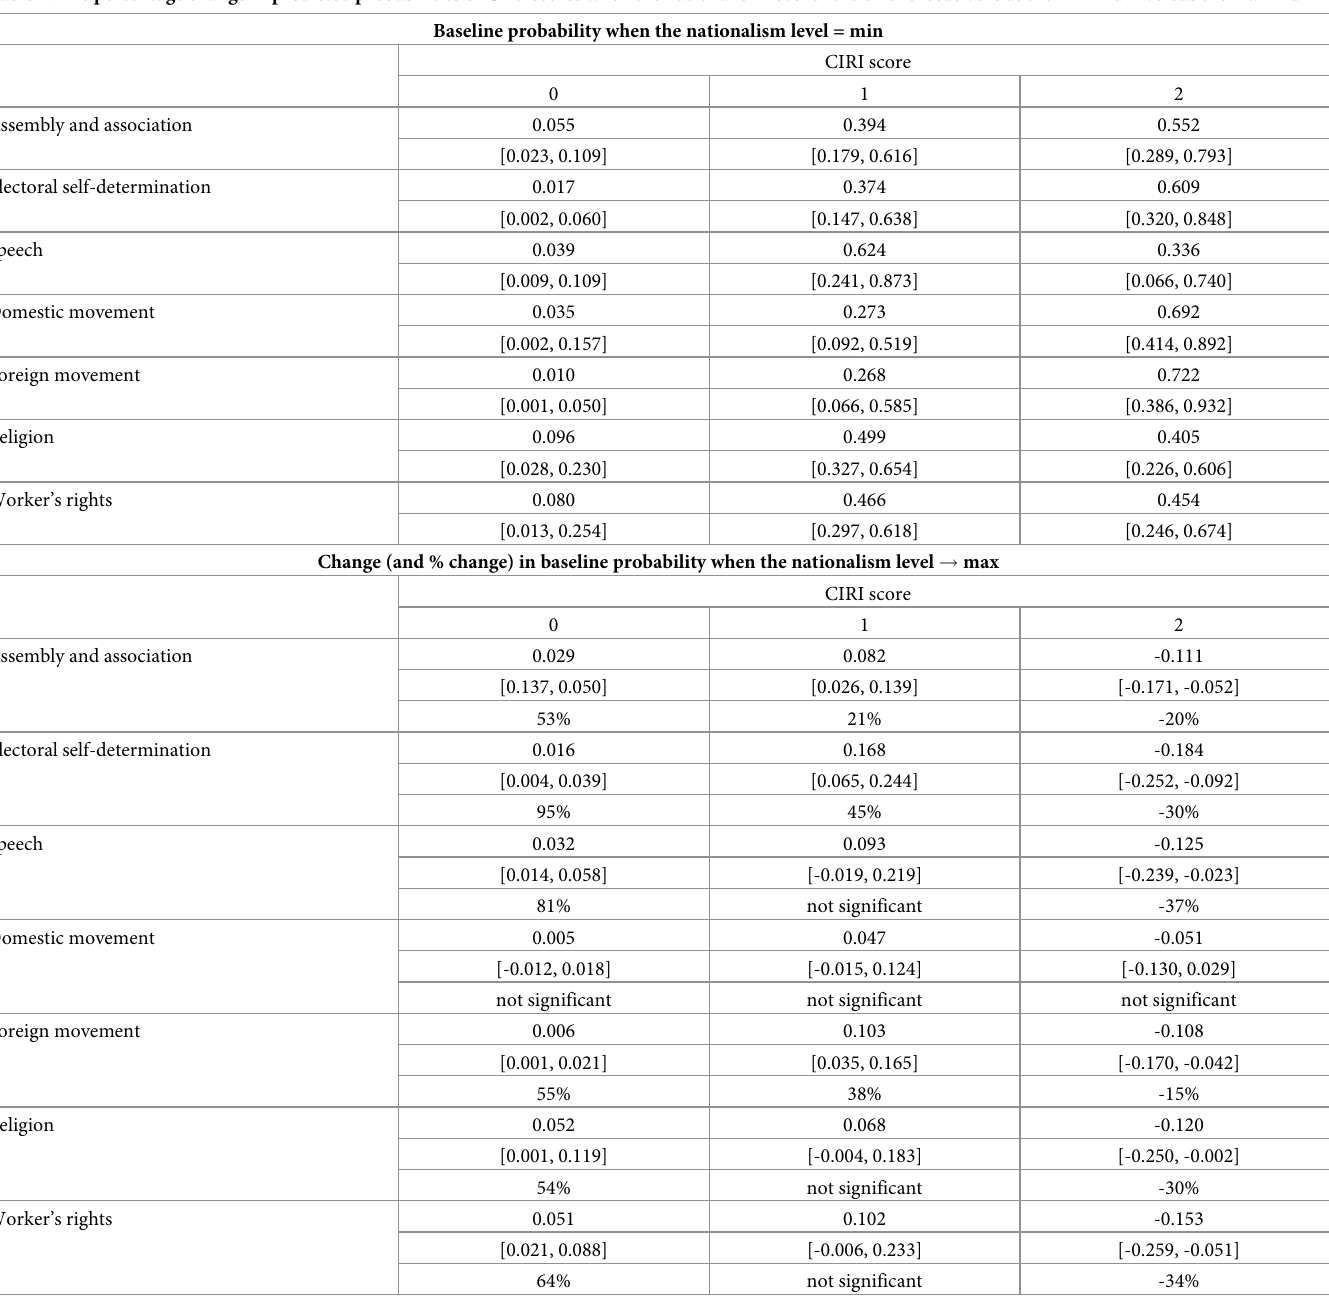
Table 4. The percentage change in predicted probabilities of CIRI scores when the nationalism level of the chief executive is at the minimum versus the maximum. Baseline probability when the nationalism level =